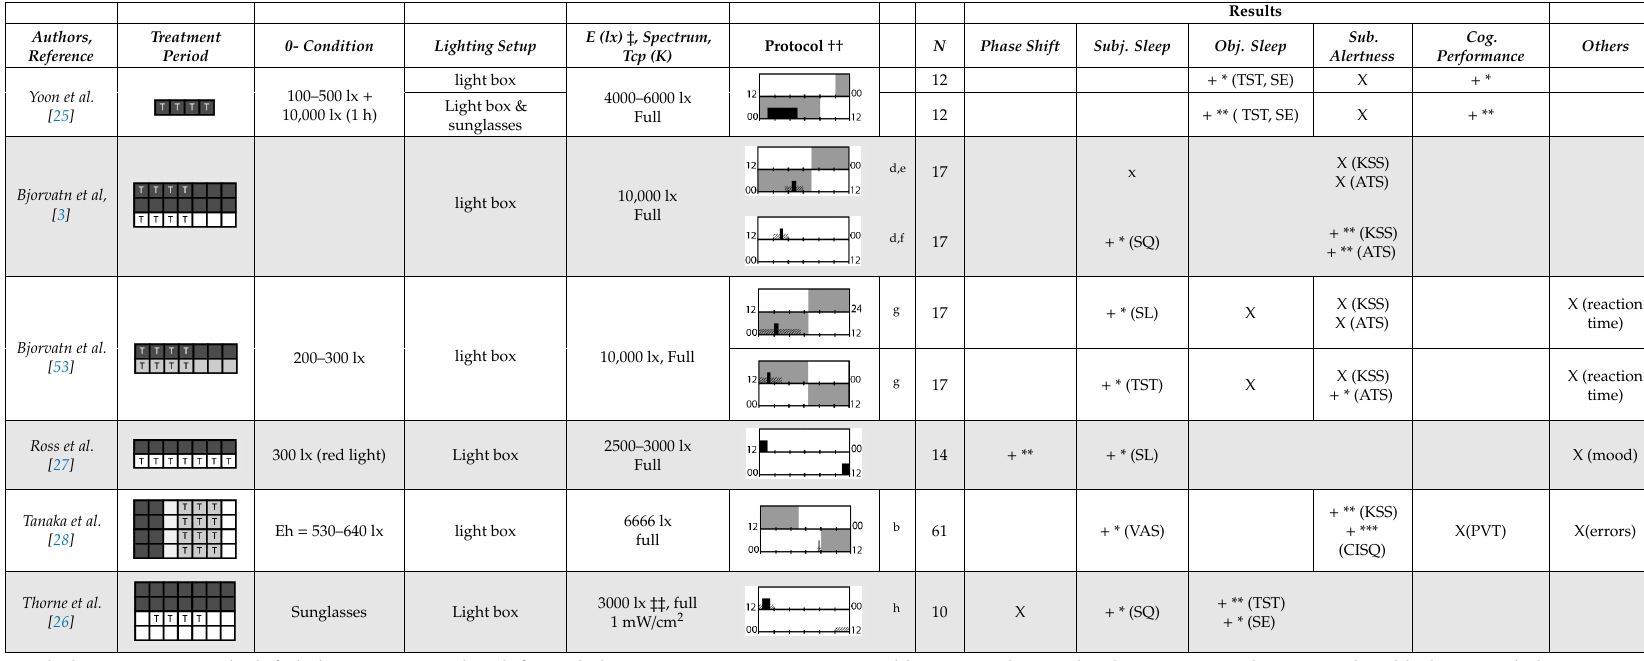
Table A2. Field studies using scheduled light exposure for night-shift workers.